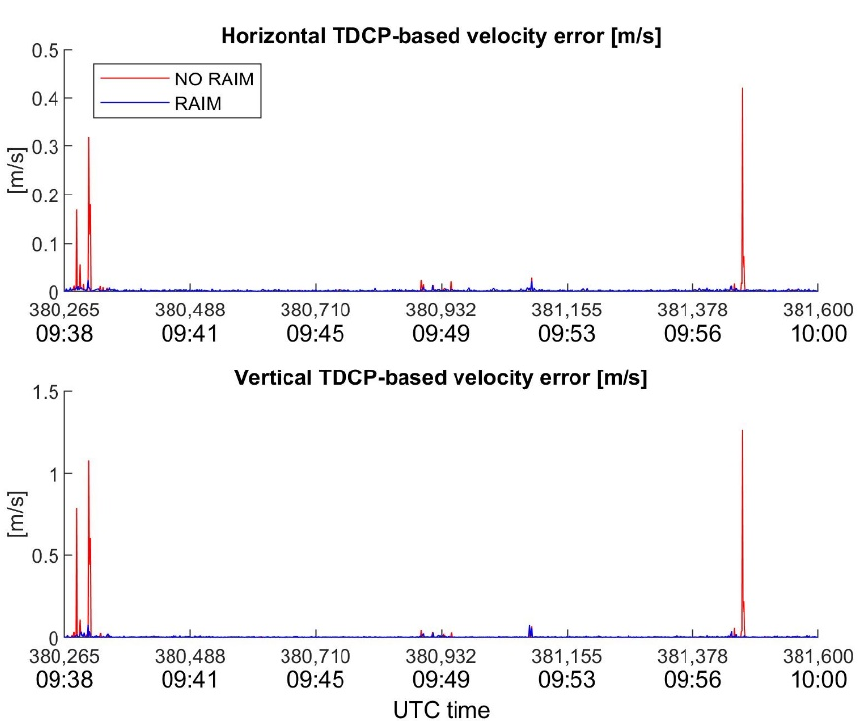
Figure 11. u-blox horizontal and vertical TDCP-based velocity errors as function of time, with and without RAIM application.